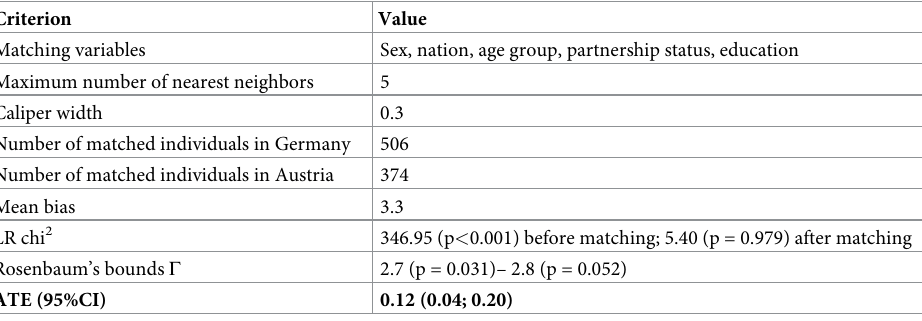
Table 3. Model specifications and outcome of propensity score